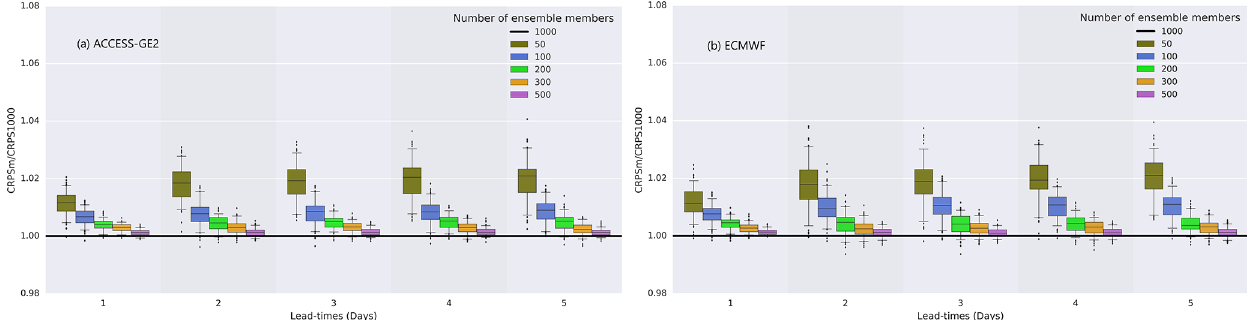
Figure 3. Sensitivity of ensemble size to forecast accuracy with reference to a 1000-member sample for rainfall forecasts (a) ACCESS–GE2 and (b) ECMWF for the Tully River at Euramo site (QLD).